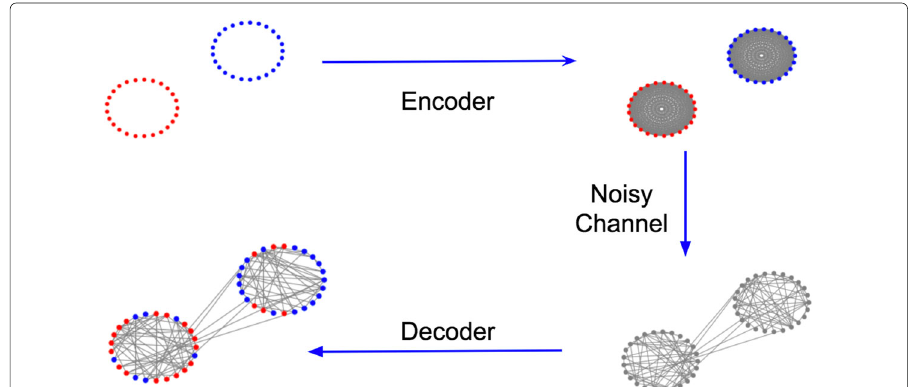
Fig. 1 Community detection as a decoding task of a message transmitted along a noisy channel. A message made up of community assignments is formed into a network structure through an encoder. The codeword is then transmitted trough a noisy channel. The channel noise delete any information regarding the assignment of nodes to communities, and further deteriorates the network structure by deleting/adding edges. The observed network is received at the end of the noisy channel, and its structure is used to decode the original